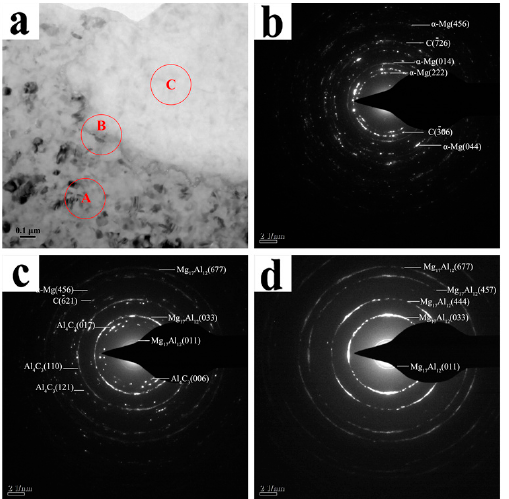
Figure 17. TEM analysis images of the AZ91D/2.0 wt% Grp with holding time of 15 min: ( a ) TEM bright-field images; ( b ) SAED pattern of the region marked with A; ( c ) SAED pattern of the region marked with B; (d) SAED pattern of the region marked with C.